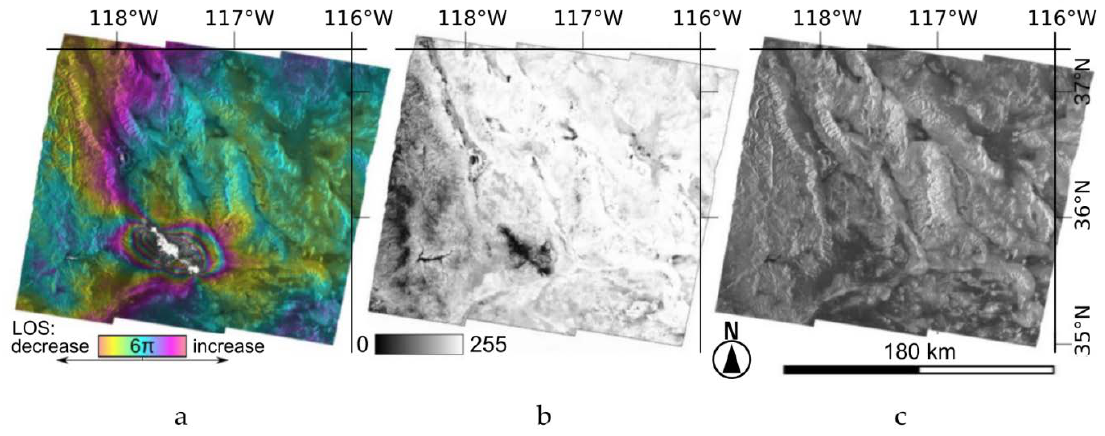
Figure 10. Additional LiCSAR interferometric products over Ridgecrest earthquake (4 July 2019) of frame 071D_05377_131313 (epochs from 4 and 16 July 2019): ( a ) co-seismic unwrapped phase, ( b ) coherence image (values stored in 8 bits) and ( c ) radar intensity image from a post-seismic